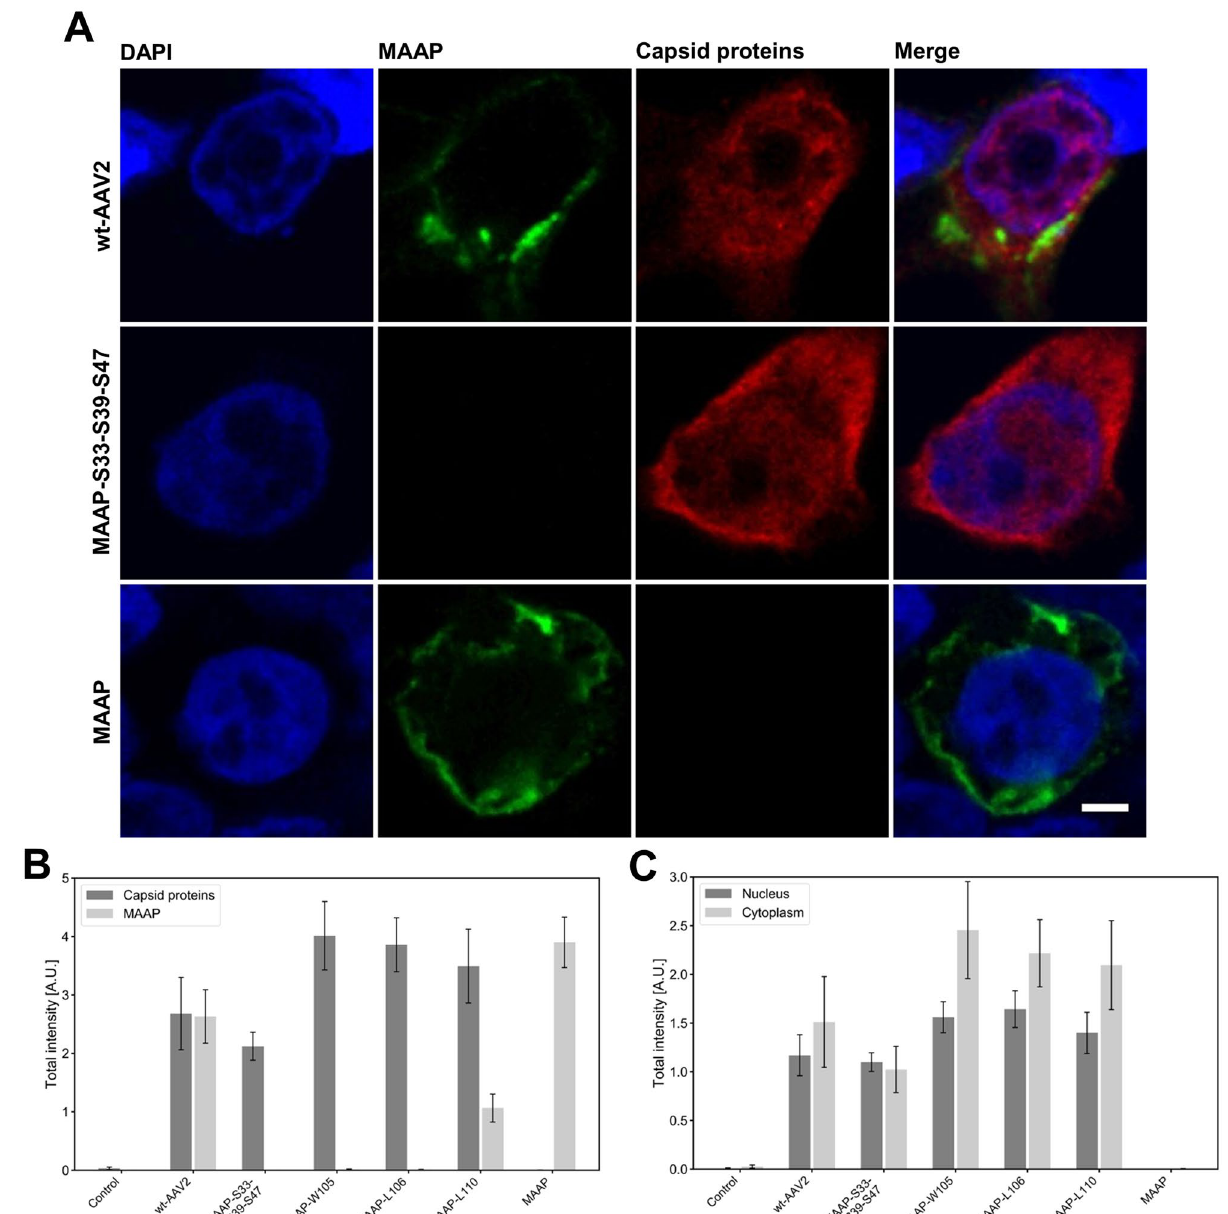
Figure 5. Localization and intensity of MAAP and AAV-2 capsid proteins in transfected cells. ( A ) Representative confocal images of intracellular localisation of MAAP and capsid proteins at 24 hpt. Cells were co-transfected with wt-AAV2 and MAAP-S33-S39-S47 variant together with Ad helper plasmid, or with recombinant MAAP expression plasmid without Ad helper plasmid. The cells were immunolabelled with polyclonal antibody against MAAP (green) and monoclonal antibody against viral capsid proteins VP1, VP2 and VP3 (red). Blue corresponds to DAPI staining. Scale bars, 3 µm. For analyses, the cells were either mock transfected (n = 19), co-transfected with wt-AAV2 (n = 11), MAAP-S33-S39-S47 (n = 19), MAAP-W105 (n = 20), MAAP-L106 (n = 17), MAAP-L110 (n = 20) together with Ad helper plasmid, or transfected with the recombinant MAAP plasmid (n = 18). ( B ) Quantitative analyses of the total intensities of MAAP (light grey) and capsid proteins (dark grey) at 24 hpt. ( C ) Quantitative analyses of the relative intensity of nuclear (dark grey) in comparison to cytoplasmic capsid proteins (light grey) at 24 hpt. For analysis, the cells were immunolabelled with antibodies against viral capsid protein VP1, VP2 and VP3 (red) and the nuclear boundary segmentation was based on distribution of DAPI-labelled chromatin (blue). The error bars show the